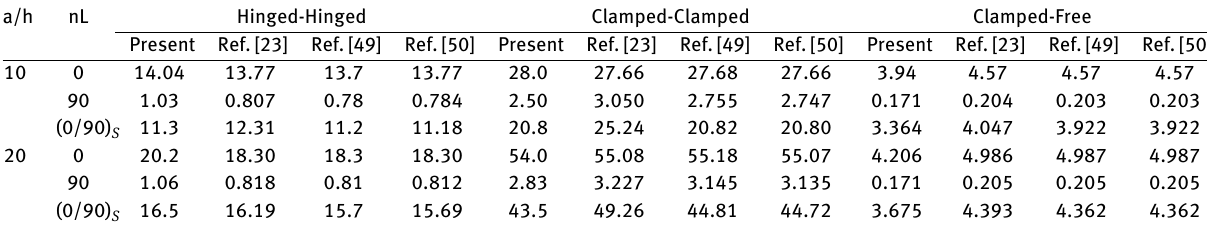
Table 2: Validation study for dimensionless buckling load for laminated composite beam for different layups and thickness ratio a/h nL Hinged-Hinged Clamped-Clamped Clamped-Free